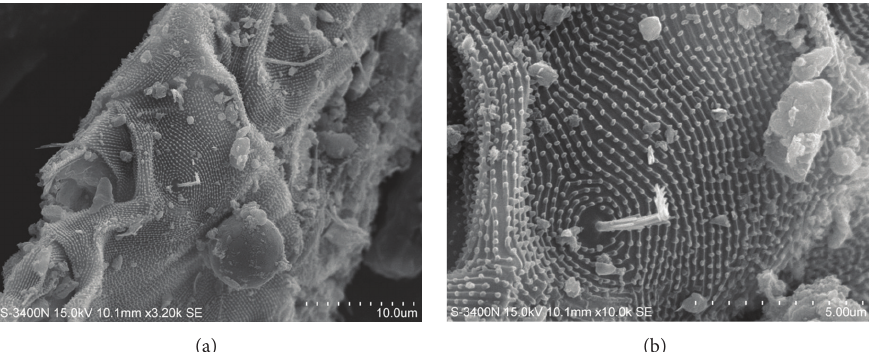
Figure 3: (a) Fragments of unknown insect from a snow sample taken in the area of the Ring Motorway in Birobidzhan. (a) Magnification × 3200. (b) Magnification ×